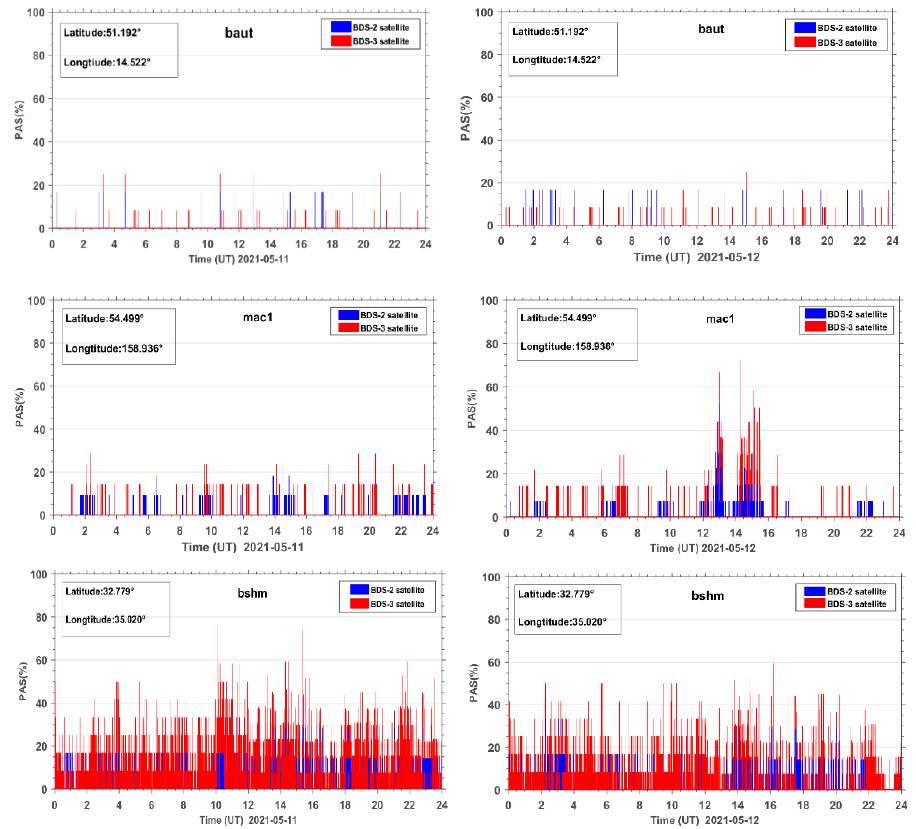
Figure 4. PAS time series at three BDS stations, that is baut, mac1, and bshm, during the reference day (11 May 2021) and the geomagnetic storm day (12 May 2021).